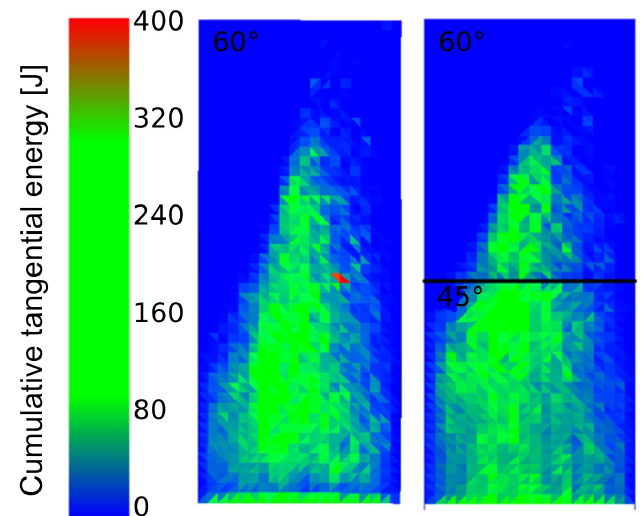
Figure 14. Cumulated tangential energy after 60 s of simulation on the chute, for 900 Mg/h.